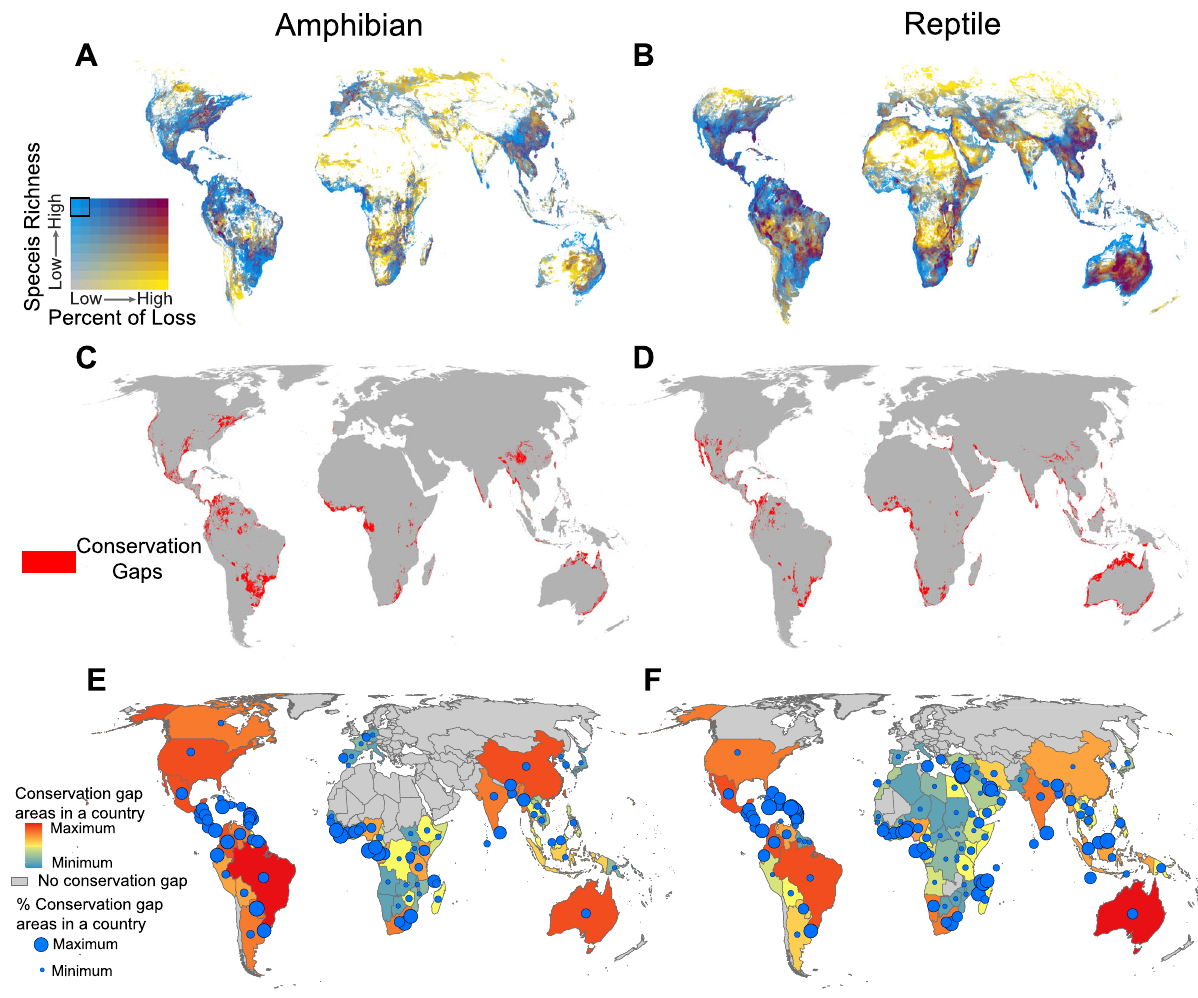
Fig.3|Conservationpriorityandconservationgapsforglobalherpetofaunaby 2070(RCP4.5). Bivariatemapsshowingspeciesrichnessversuspercentofspecies loss for A amphibians and B reptiles. Each colorchangemeans a 10% quantile shift in either variable. Noteworthy, areas in blue represent areas that currently fall into the top species richness category and that are expected to suffer a low percent of species loss due to climate changeby 2070; in short, they are climate-robust areas ofhighspeciesrichness. C , D representconservationgaps(areasfallingintothetop